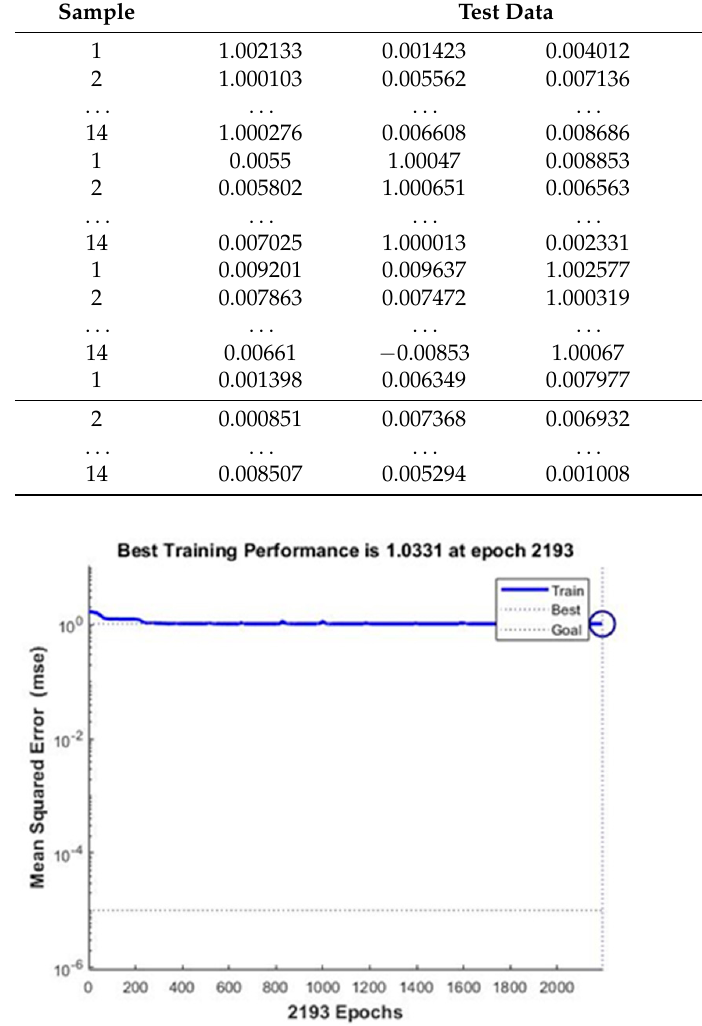
Figure 14. The number of iterations of the BP algorithm.